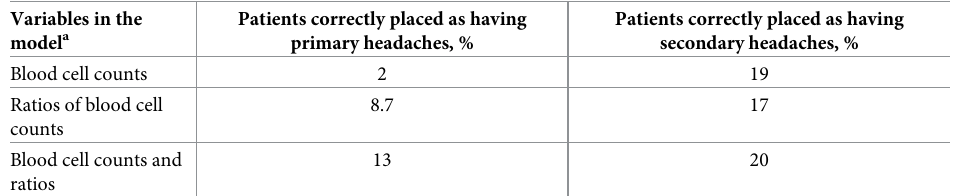
Table 4. Hypothesis testing results using the Hotelling T 2 -test (n =